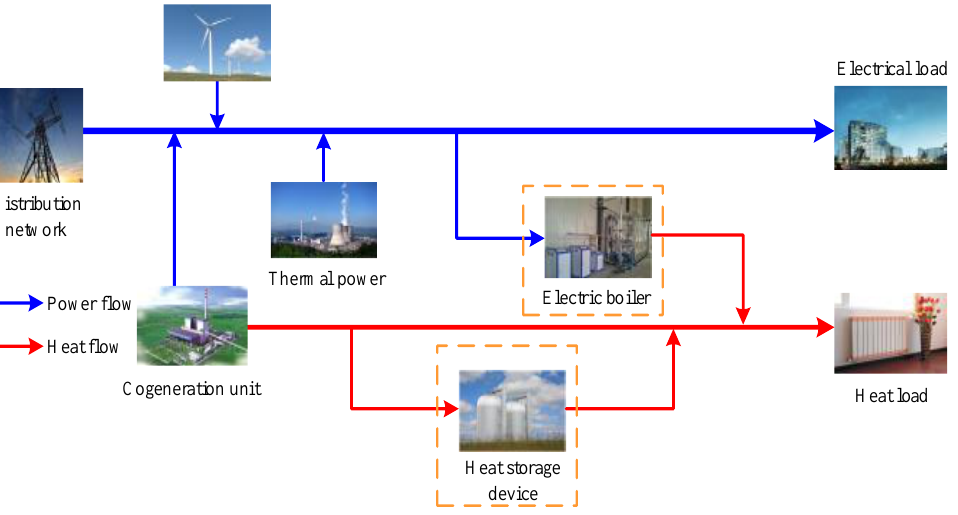
Figure 5. System structure diagram with a heat storage device and electric boiler.